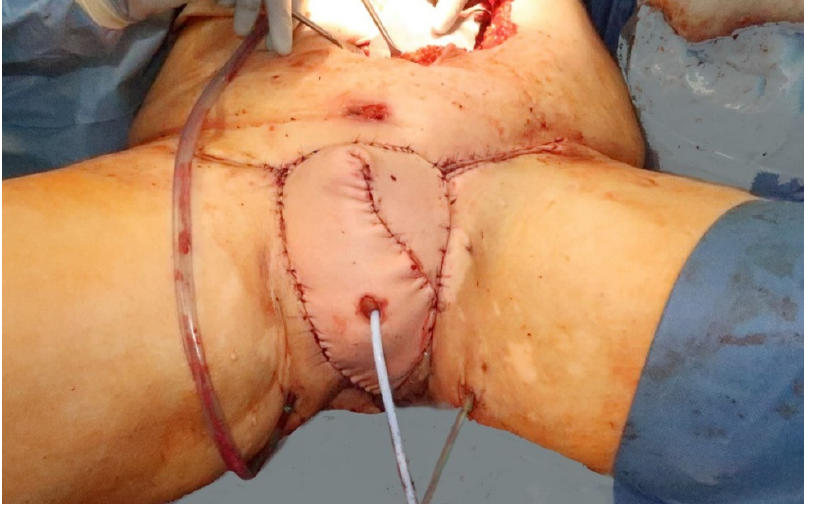
Figure 5. Immediate postoperative results after flap inset and reconstruction of the neourethra.